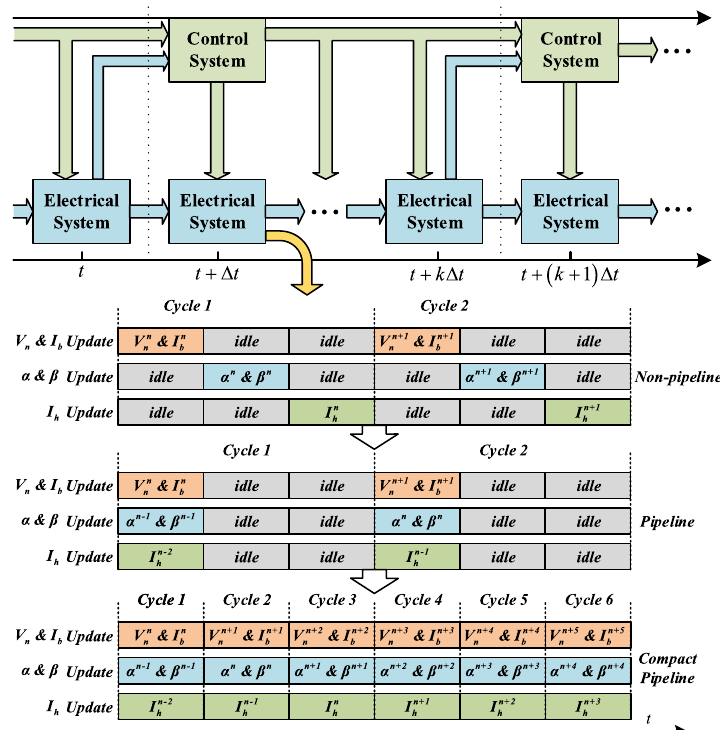
Fig. 6 Cooperation between FPGA and CPU